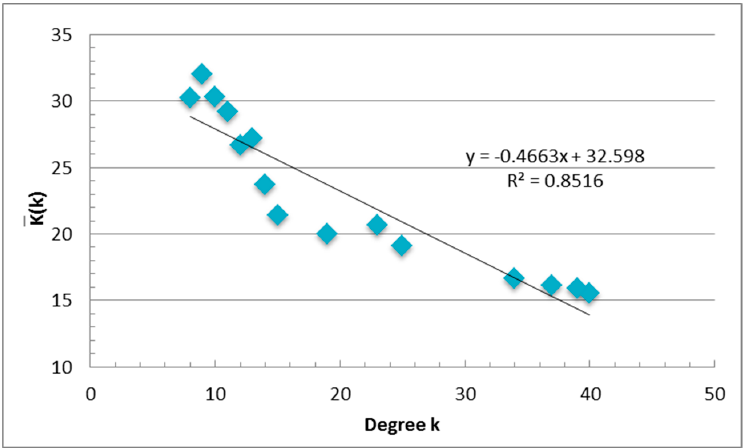
Figure 9. The degree correlation of nIFMA.